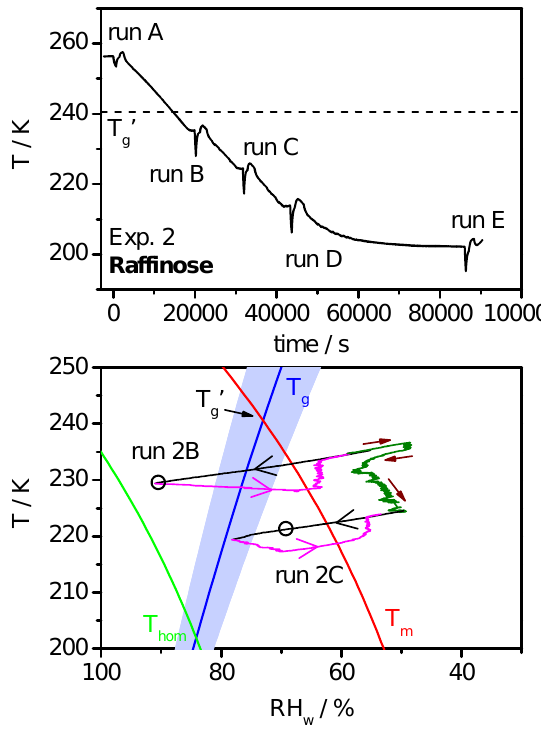
Fig. 7. Top panel: Temporal evolution of the AIDA gas tempera- ture during Exp. 2 with aqueous raffinose aerosol particles. Bottom panel: Experimental trajectories of expansion runs 2B and 2C as a function of RH w (see also Fig. 1). Different colours and arrows are used to underline the temporal order of the experiment, as described in detail in the text. The circles denote the onsets of ice nucleation during the expansion runs, whose further AIDA records are shown in Fig.